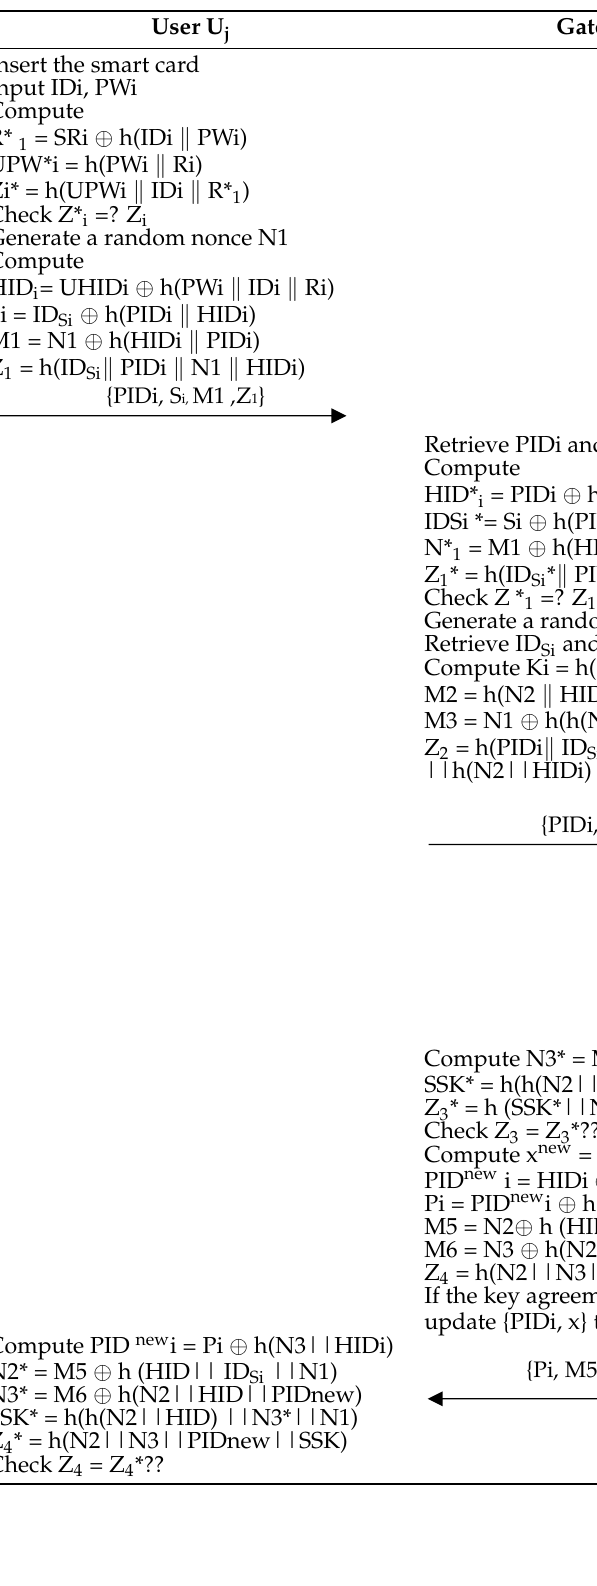
Table 5. Login and authentication Table 5. Login and authentication phase. Table 5. Login and authentication phase. Table 5. Login and authentication phase. Table 5. Login and authentication phase.